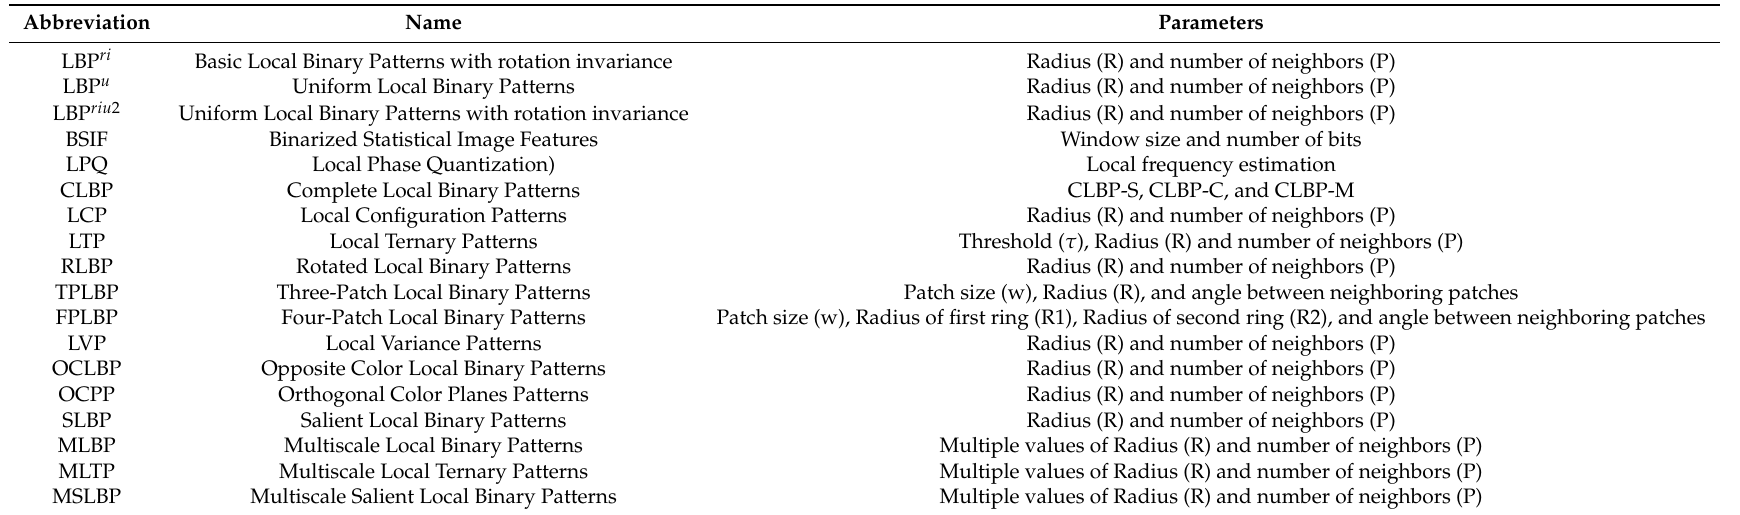
Table 1. Tested LBP